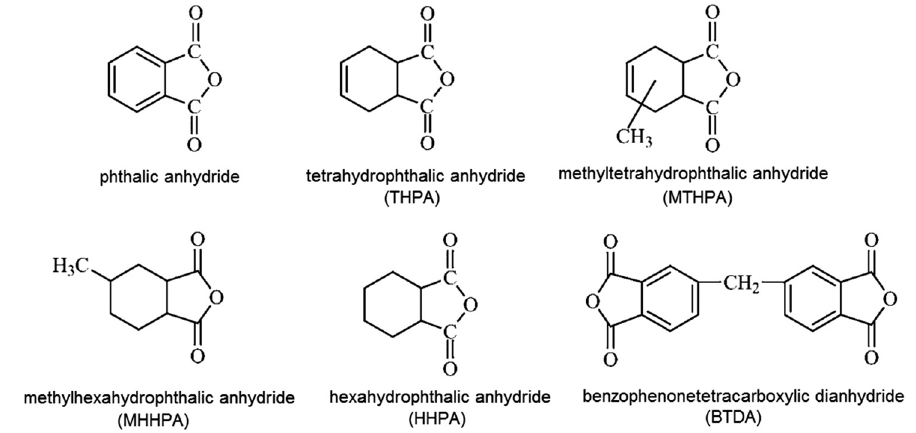
Figure 7: Chemical structure of anhydride epoxy resins [ 37 ]